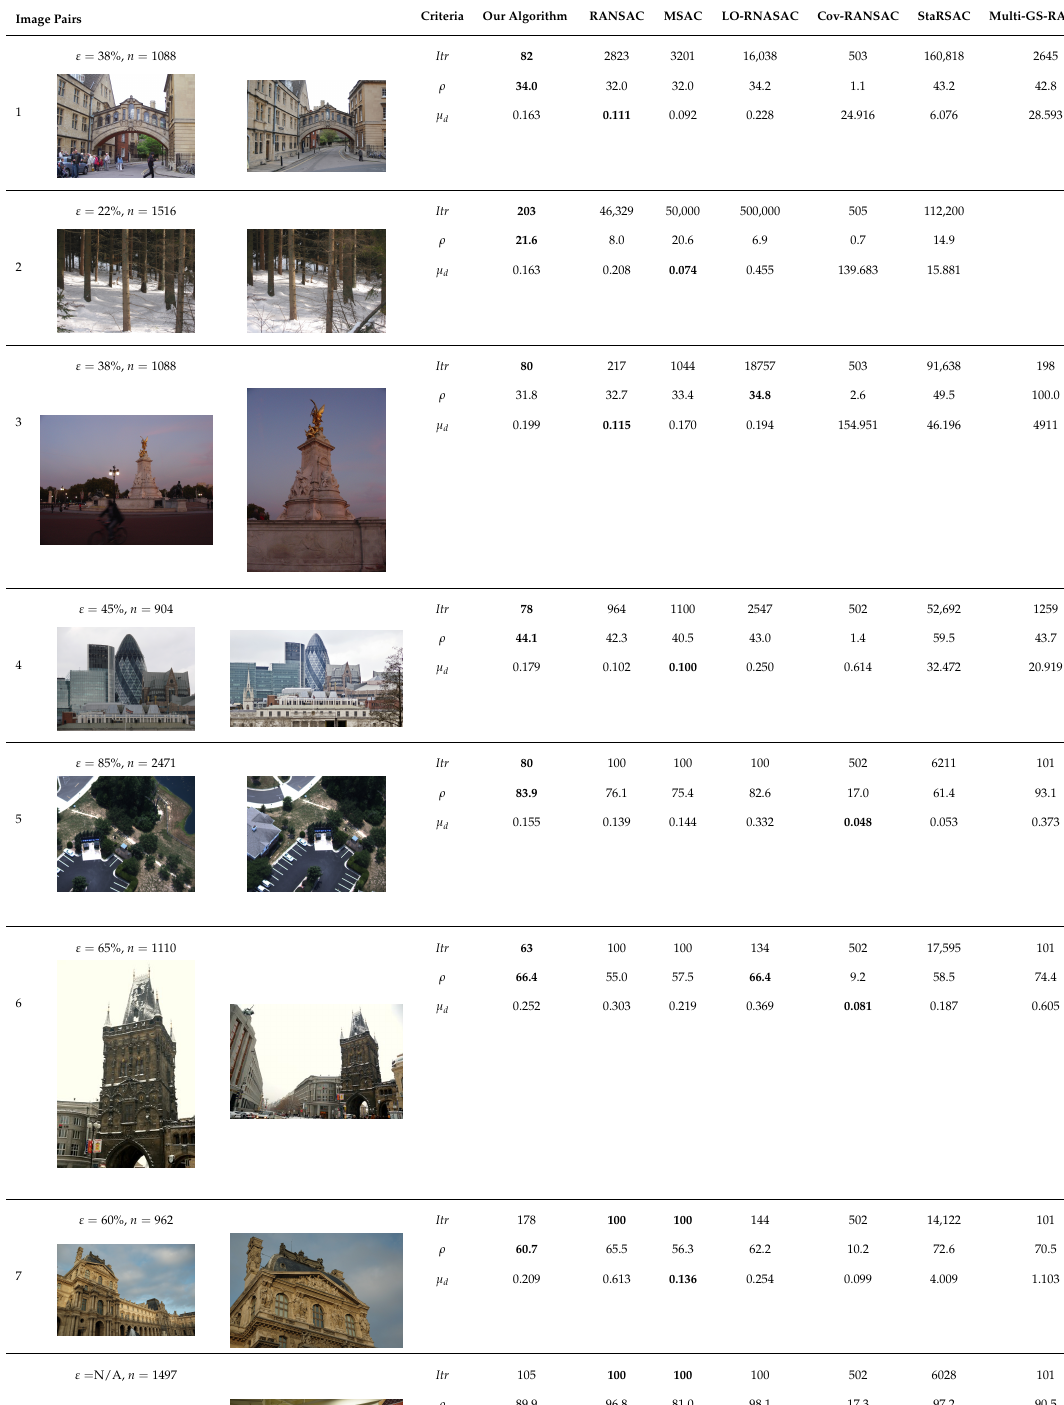
Table 3. Performance of the proposed algorithm and other techniques on real data.